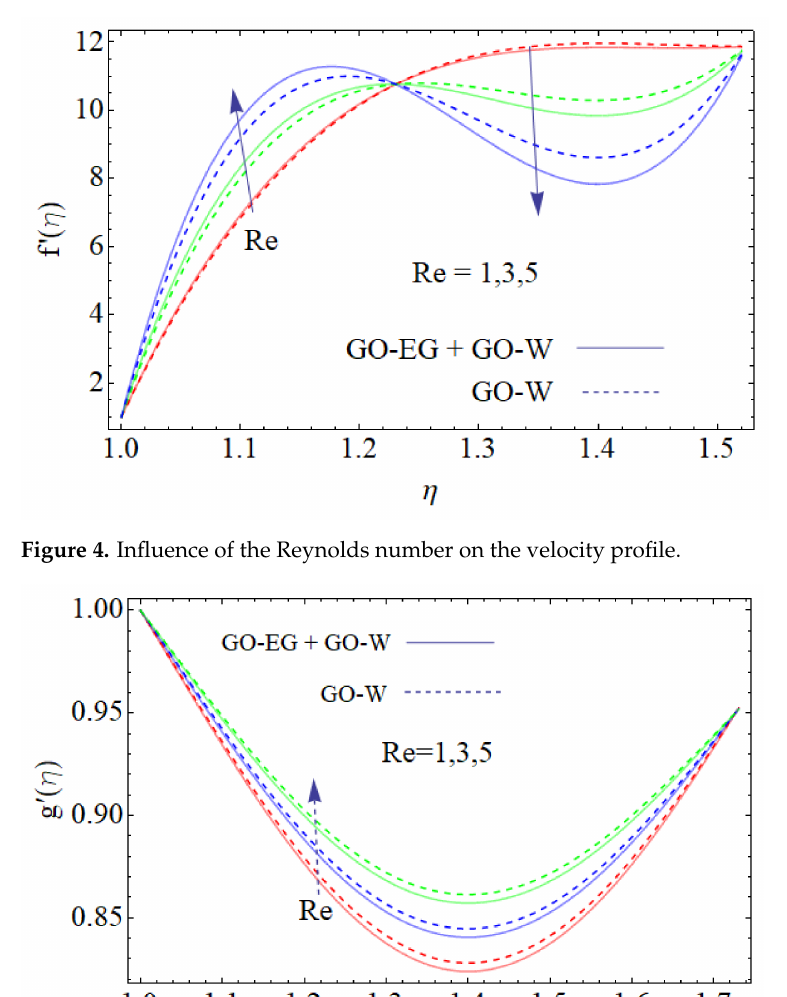
Figure 3. Influence of the injection parameter on the velocity profile.